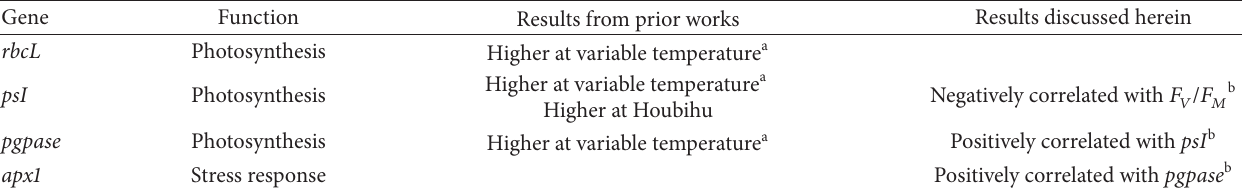
Results discussed